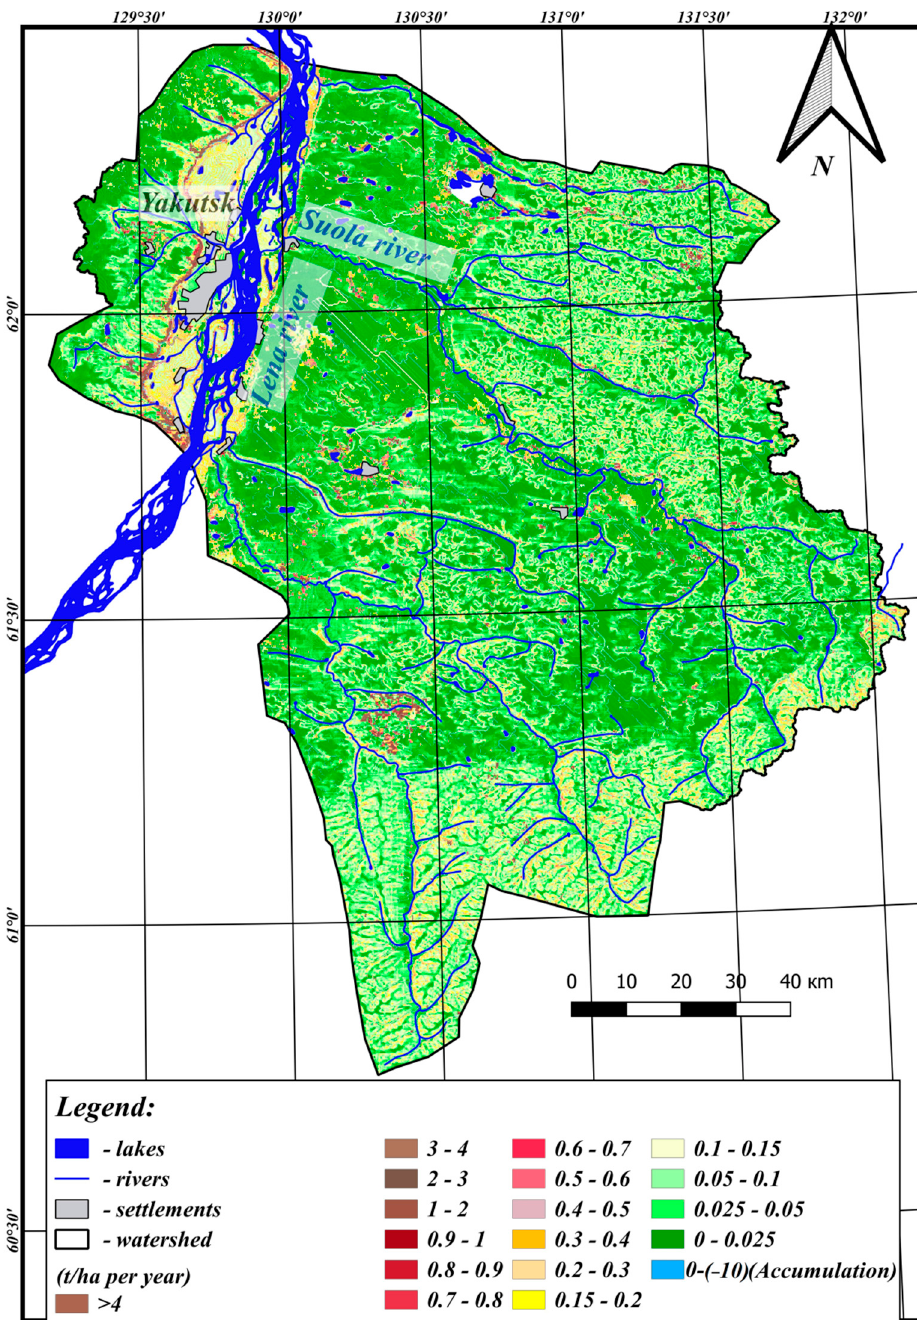
Figure 7. A spatial model of net water erosion of the «Yakutsk» catchment area (1986–2019 period).